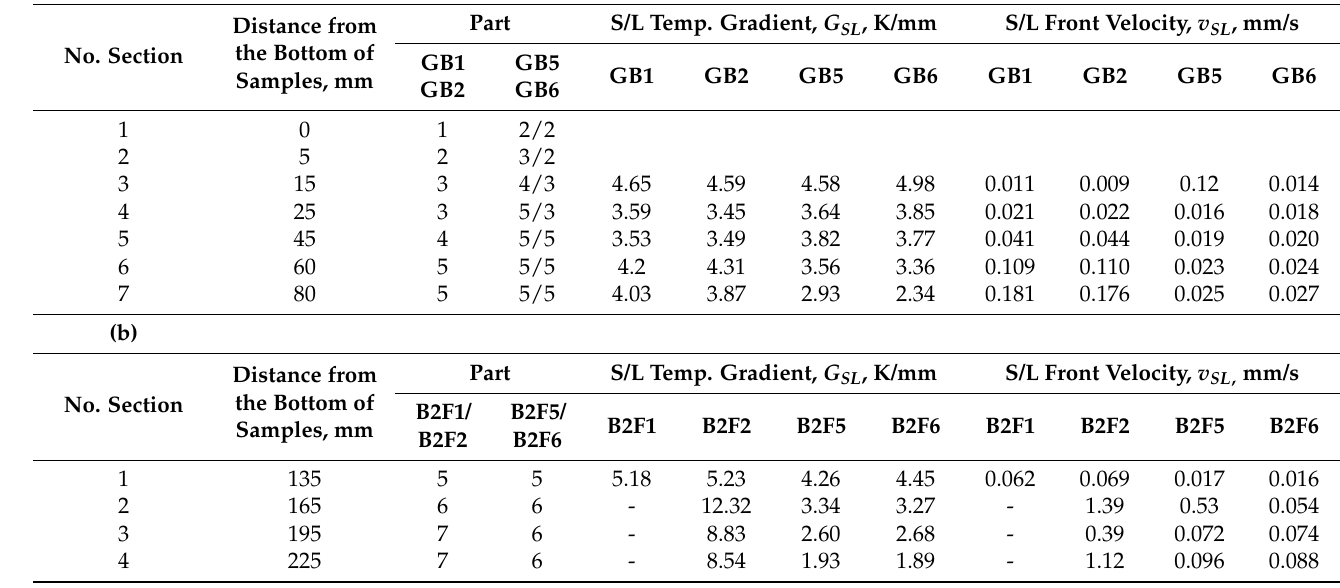
Table 2. (a) The solidification parameters of GB samples at the investigated cross and longitudinal sections. (b) The solidification parameters of B2F samples at the investigated cross and longitudinal sections